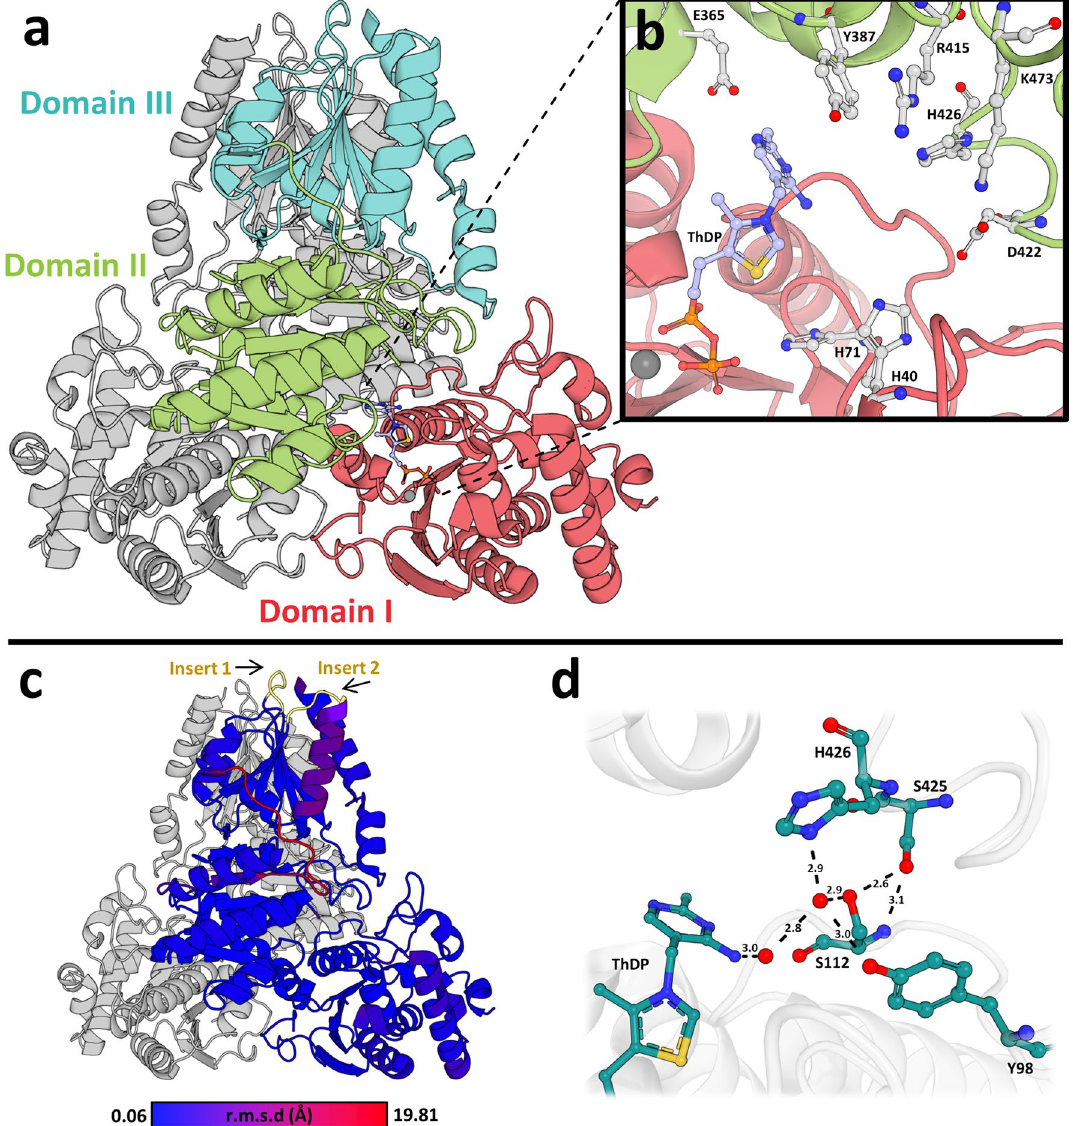
Figure 2. Overview of the holo structure of ΔMtDXPS . ( a ) Overview of the Δ Mt DXPS structure with highlighted domains. Domain I (res 1–312) in red, domain II (res 313–483) in green and domain III (484–638) in cyan. ( b ) Active site with important residues for catalysis shown in stick representation. ( c ) Structure colored according to C α -RMSD to the drDXPS structure (PDB ID: 2O1X ), insertion regions are colored in yellow. ( d ) Hydrogen-bonding network that stabilizes the different H426 conformation and key residues in the network. Water molecules are shown as red spheres and hydrogen bonds as black, dashed lines with distances indicated in